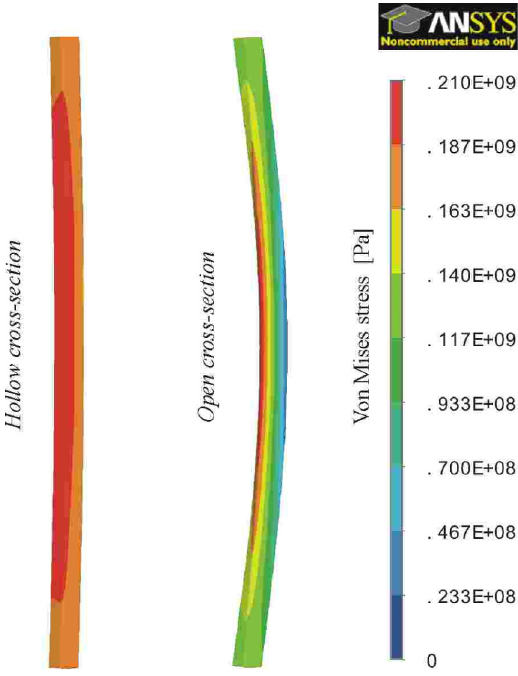
Fig. 6. Finite element analysis of column with hollow cross- section